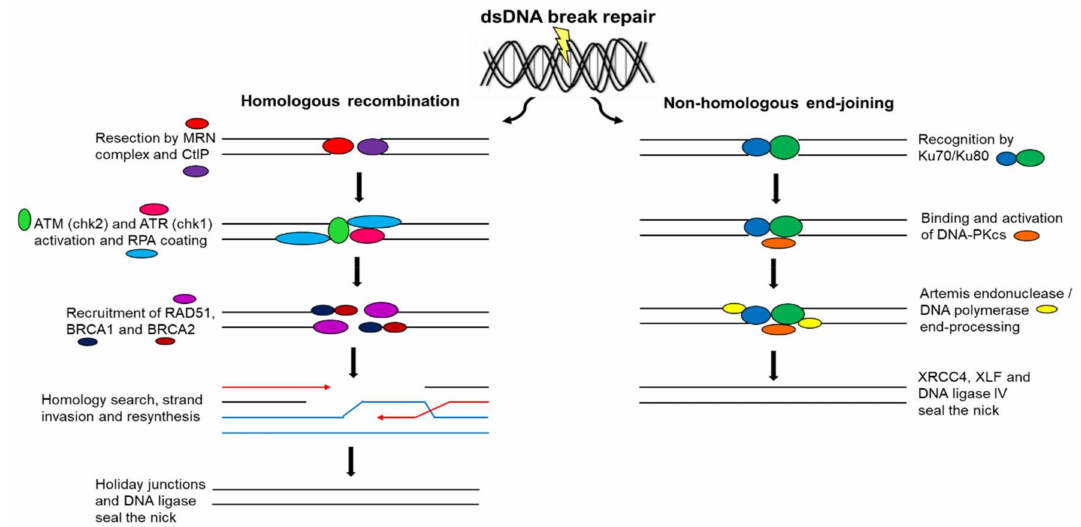
Figure 4. Double-strand deoxyribonucleic acid break repair. DsDNA breaks are repaired by HR or NHEJ. HR involves the restoration of DNA sequences using sister chromatid sequence homology as a template and functions in all phases of the cell cycle, whereas NHEJ involves damaged DNA sequence deletions and functions in only S and G 2